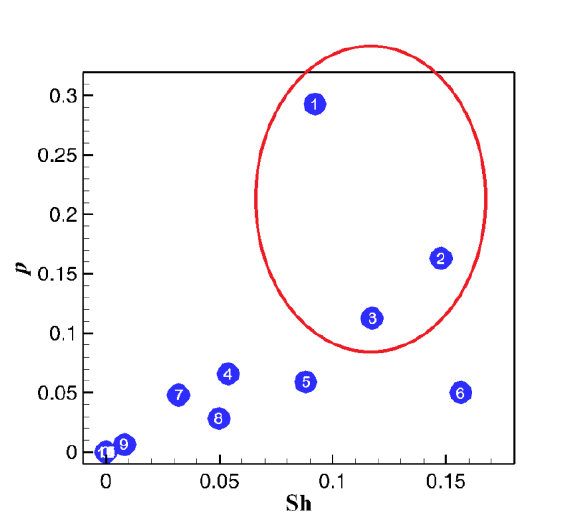
Fig. 9. OPD spectrum.